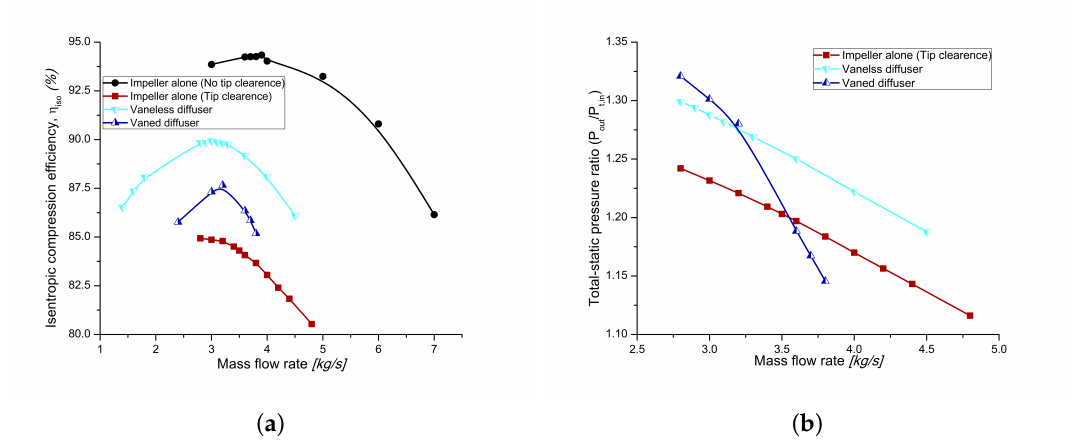
Figure 11. Performance characteristics of various configurations. ( a ) Comparison of isentropic compression efficiency of different configurations. The efficiency increases on the inclusion of the diffuser section in the impeller with the tip clearance configuration and attains a peak value near the design mass flow rate of 3.53 kg/s. ( b ) Comparison of the total-static pressure ratio of different configurations. The pressure ratio for vaned diffuser decreases at a higher rate than the vaneless diffuser configuration which indicates the vaned diffuser becomes less efficient at mass flow rate more than 3.25 kg/s.